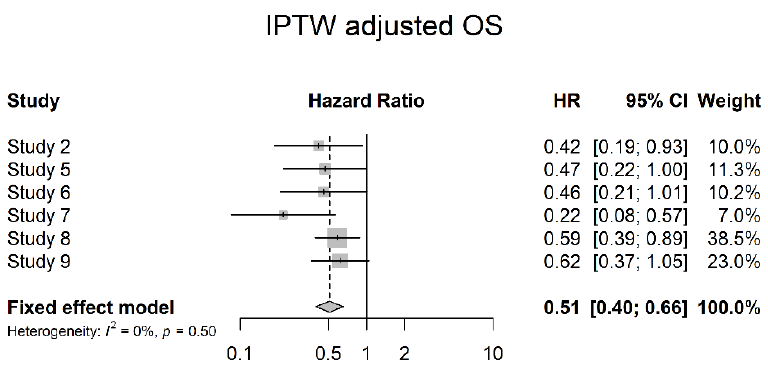
Figure 17. IPTW adjusted overall